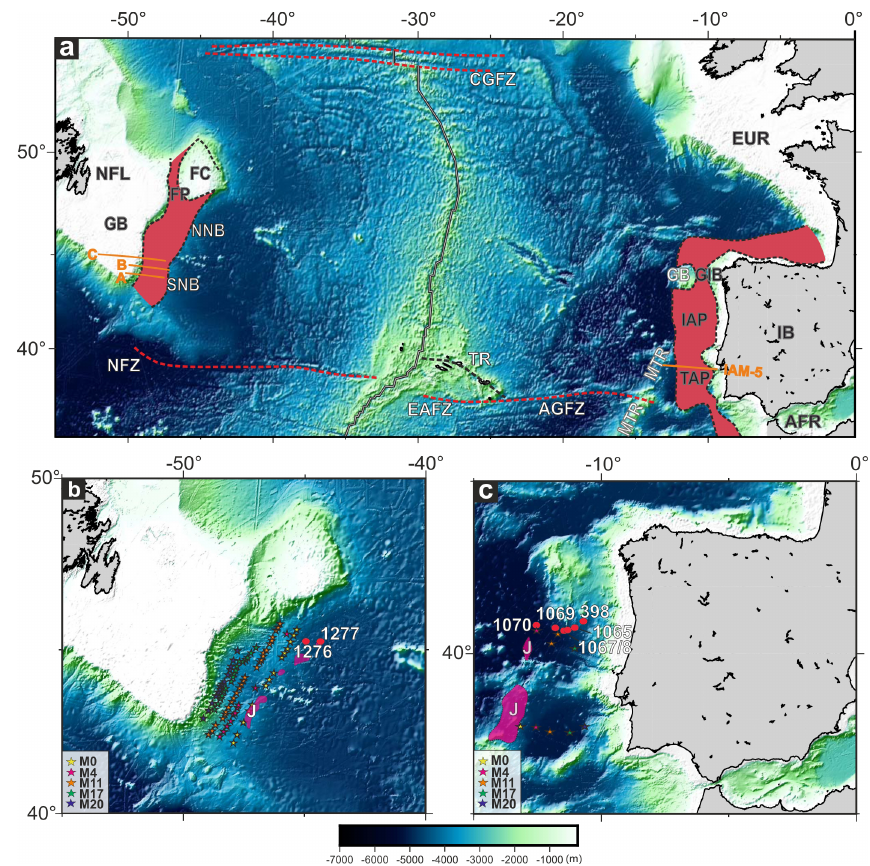
Figure 1. (a) Study area showing the location of structural and tectonic features significant to our study. Red envelopes mark the extent of the COTZ as compiled by Eagles et al. (2015). Double black line: mid-ocean ridge; red dashed lines: fracture zone traces. Orange lines: seismic profiles presented and discussed in this study. Background image is Smith and Sandwell (1997) gridded satellite altimetry. (b, c) Location of M-series magnetic isochron picks (Srivastava et al., 2000) and ODP legs 210 (Tucholke et al., 2007), 103 (Boillot et al., 1987), and